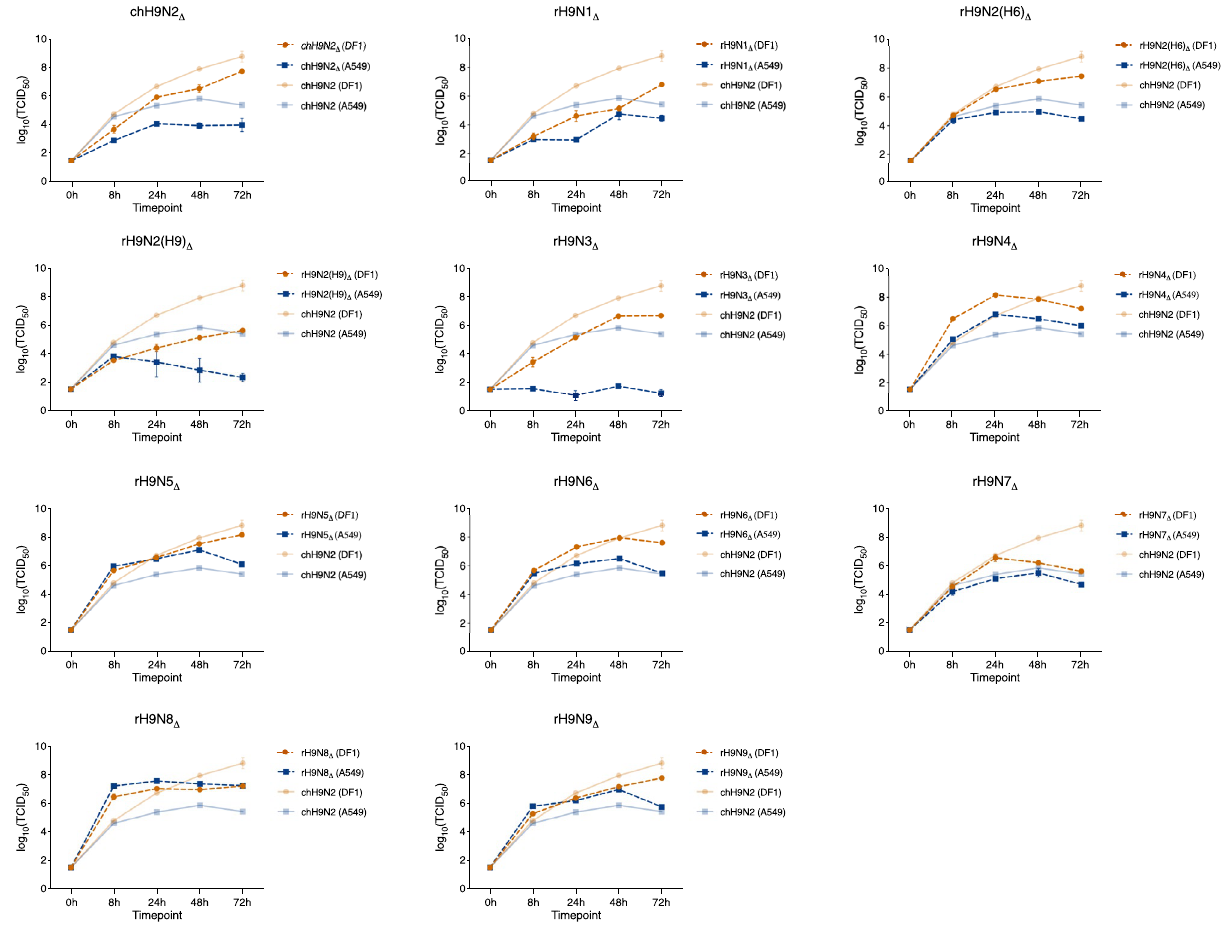
Figure 3. Replication efficiency of the rH9Nx reassortants with a 20 aa neuraminidase stalk deletion in DF-1 (orange) and A549 (blue). The log 10 (TCID 50 ) value at time point 0 h is based on the starting TCID 50 value. Error bars represent the standard error of the mean (SEM).